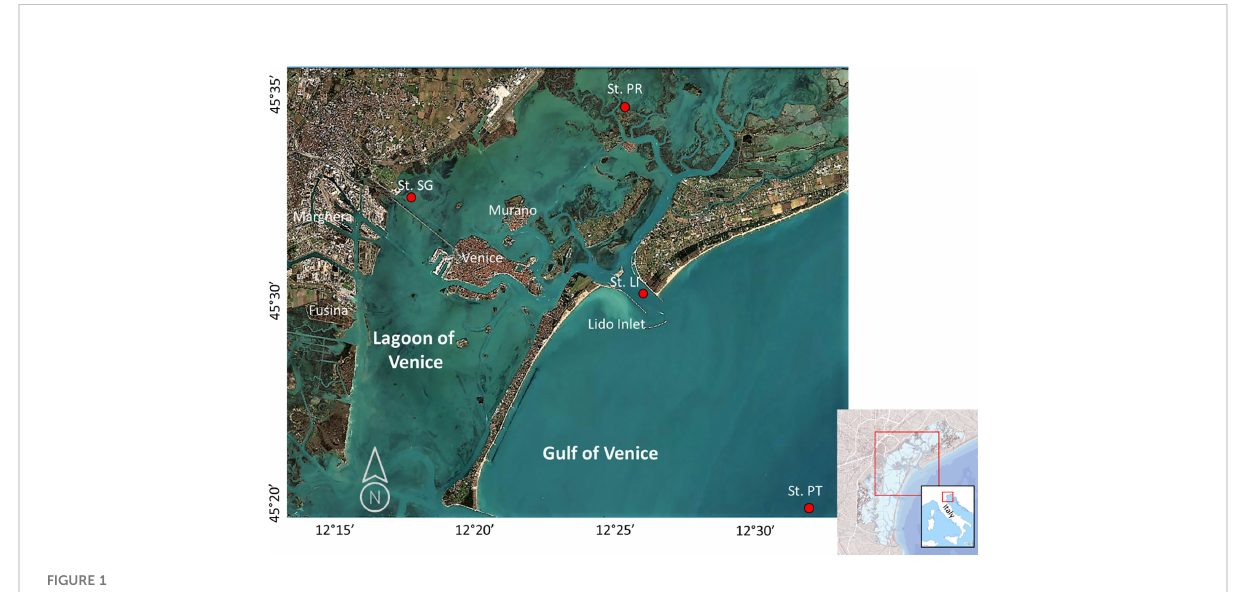
FIGURE 1 The sampling stations in the LoV and